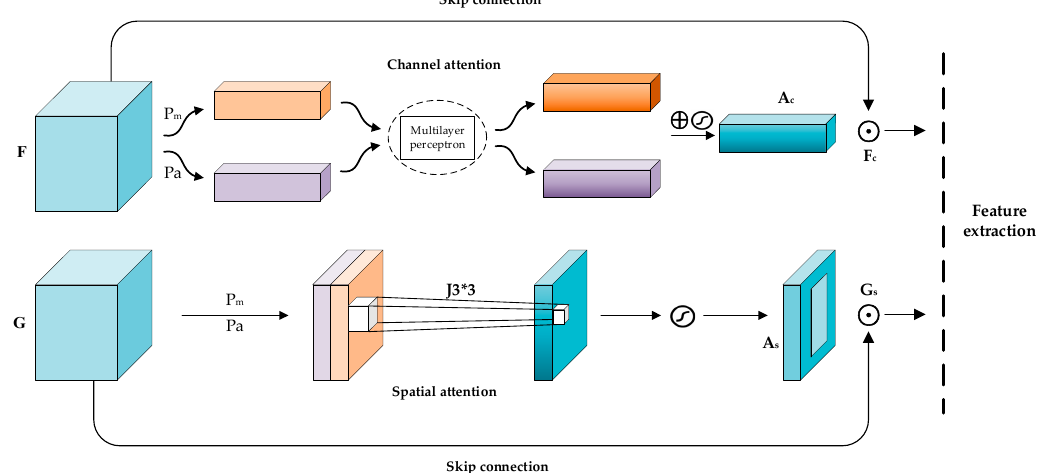
Figure 5. The structure of the proposed multi-dimensional model.